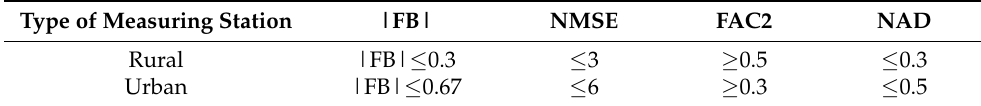
Table A1. Definition of the acceptance criteria for dispersion model evaluation. Type of Measuring Station |FB| NMSE FAC2 NAD Rural Urban |FB| ≤ 0.67 ≤ 0.5 A model will meet the acceptance criteria if these statistical indicators satisfy the values reported in Table A1 for urban and rural types of monitoring